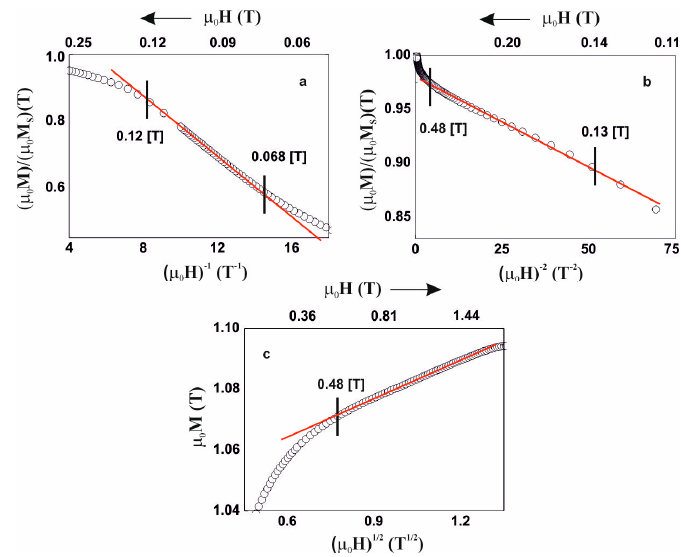
− 1 , ( b ) ( µ × 2 , µ 0 H) 0 H)